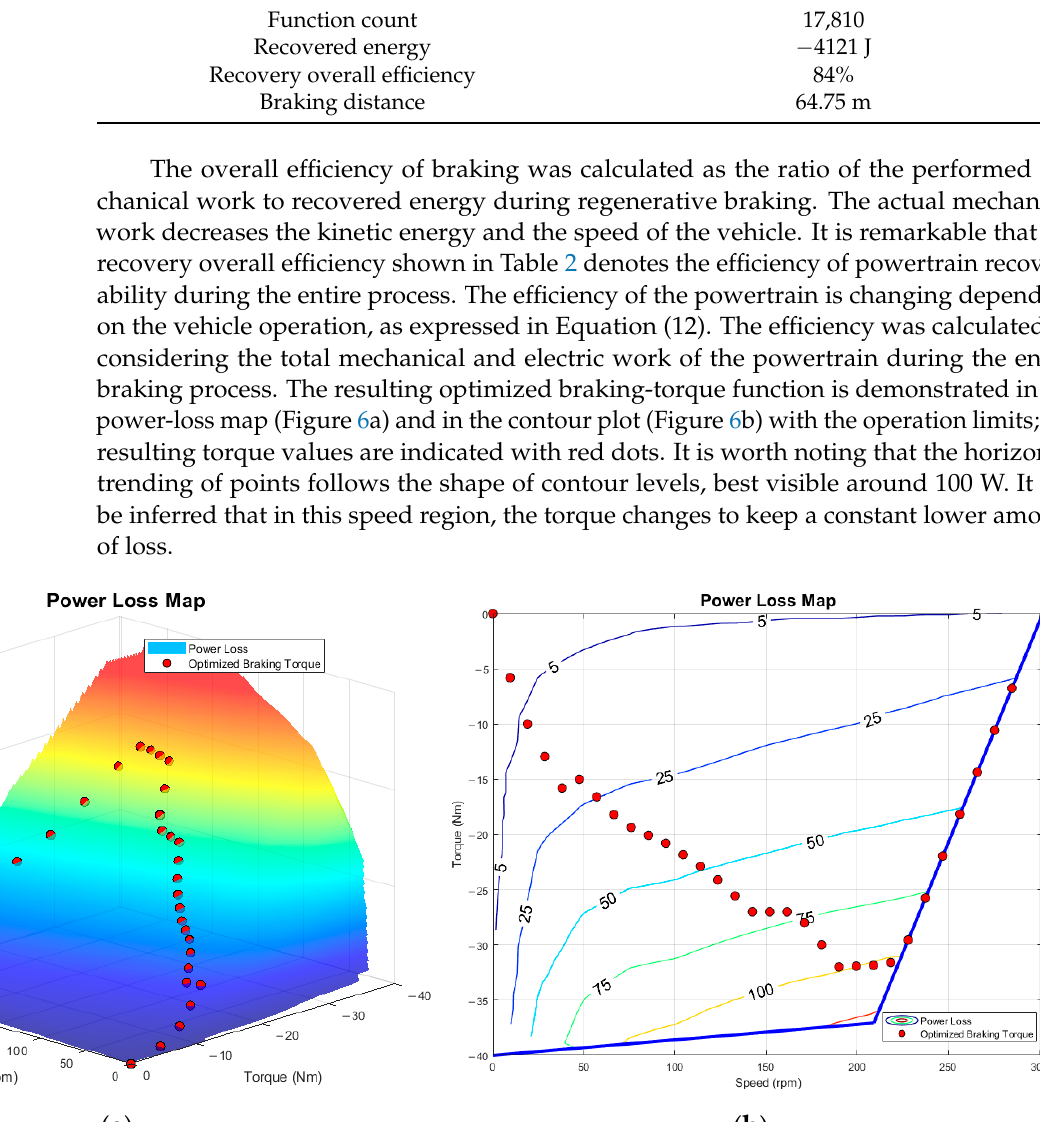
Table 2. Regenerative braking-torque optimization results.